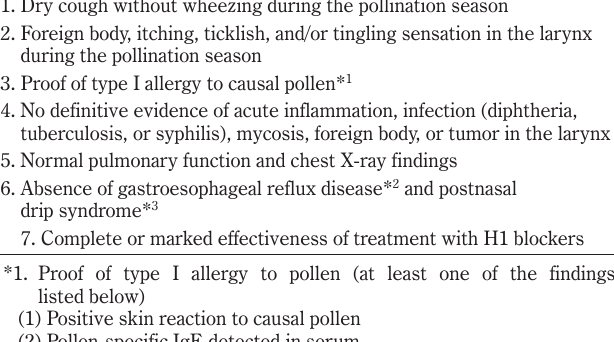
Table 3 Strict diagnostic criteria for seasonal laryngeal allergy (2011) (translated into English from the Japanese text in reference 17)